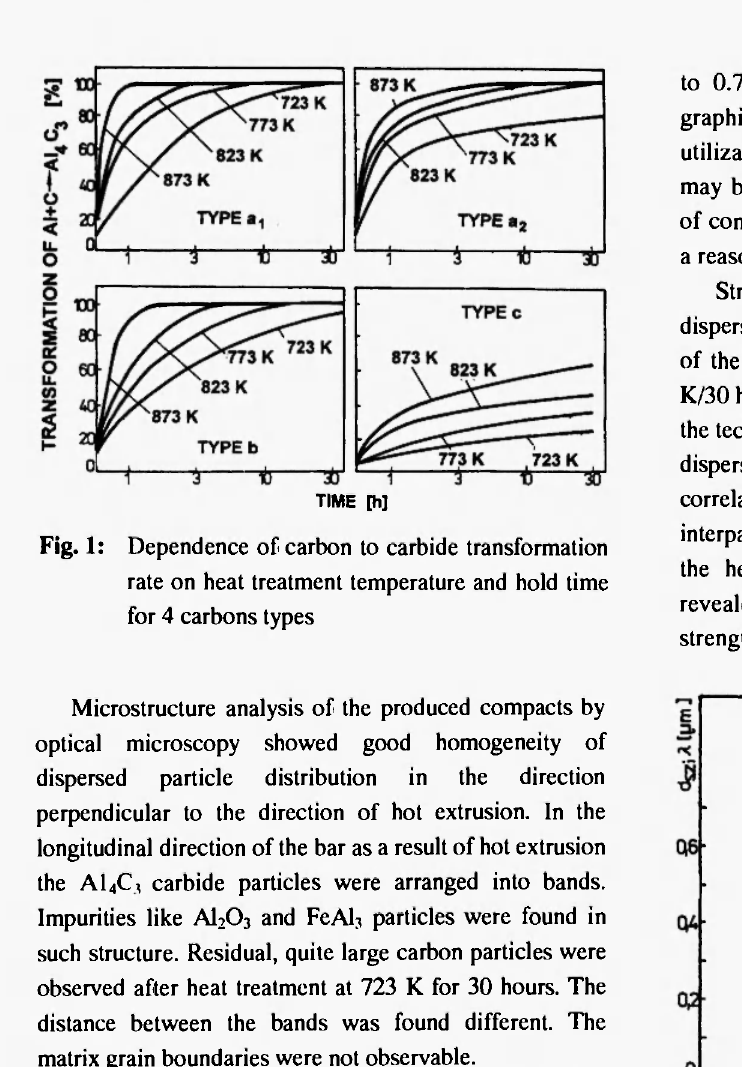
Fig. 1: Dependence of carbon to carbide transformation rate on heat treatment temperature and hold time for 4 carbons types